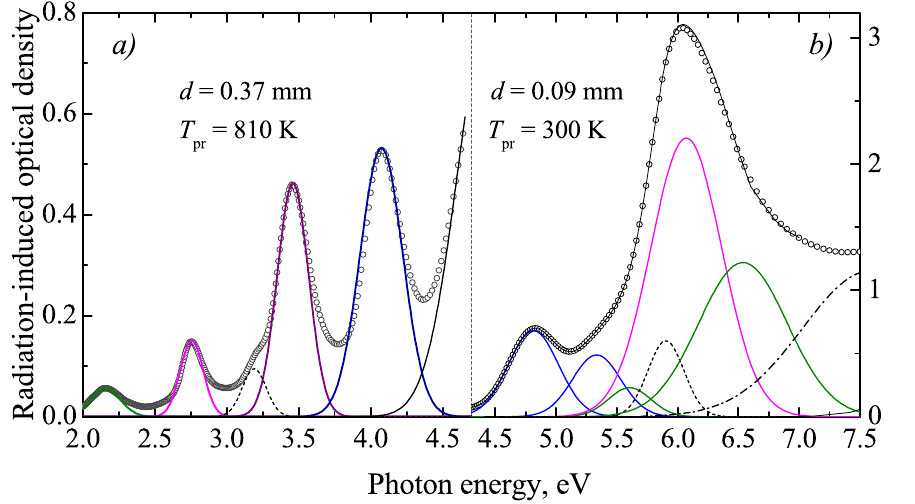
Figure 3. The decomposition of RIOA spectra (curves with symbols, οοο) into Gaussian components (color lines) for the neutron-irradiated α-Al 2 O 3 single crystals ( Φ = 6.9 × 10 18 cm -2 ). Right side—the experimental spectrum is the RIOA measured after irradiation of the sample with d = 0.09 mm; left side—the experimental spectrum is the spectrum after preheating of the irradiated sample with d = 0.37 mm to 810 K.